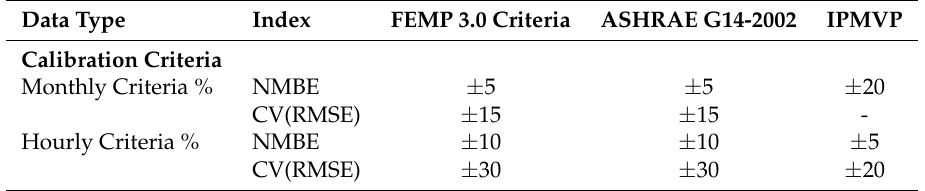
Table 3. Calibration criteria of Federal Energy Management Program (FEMP), American Society of Heating, Refrigerating and Air-Conditioning Engineers (ASHRAE), and International Performance Measurement and Verification Protocol